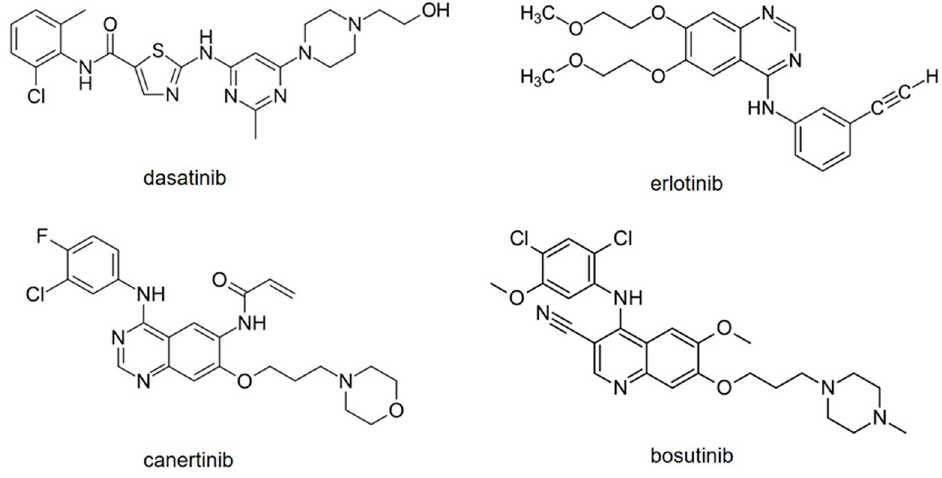
Figure 1. Structures of model